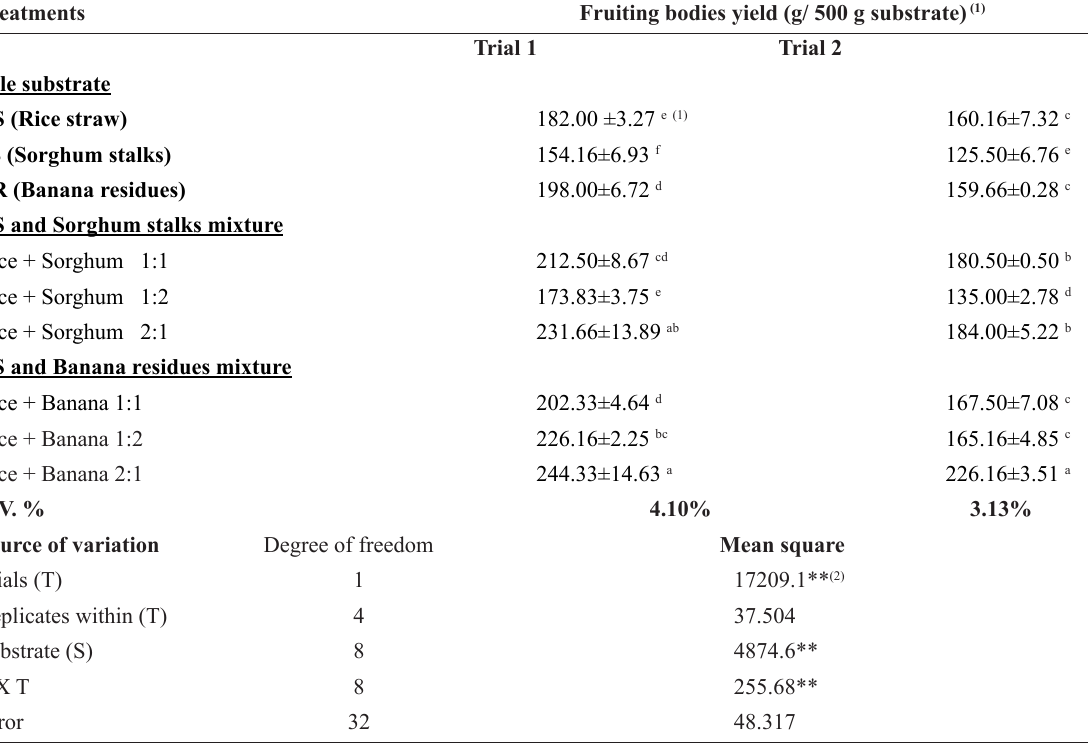
Table 1 Fruiting bodies yield of oyster mushroom ( P. ostreatus ) produced on three sole substrates and six